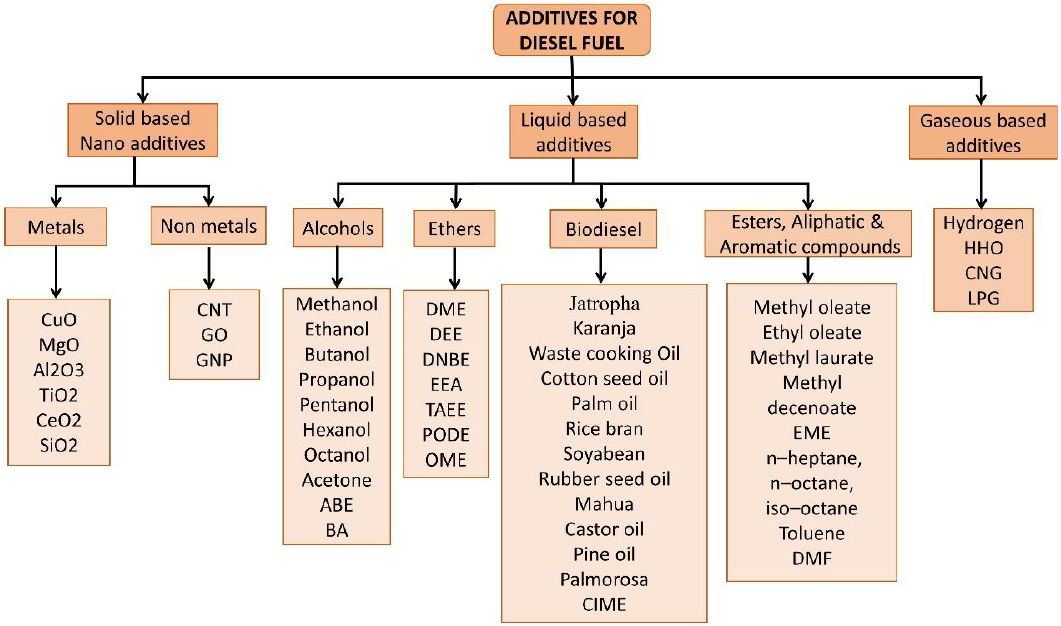
Figure 2. List of various additives used with diesel to improve spray performance and combustion properties.